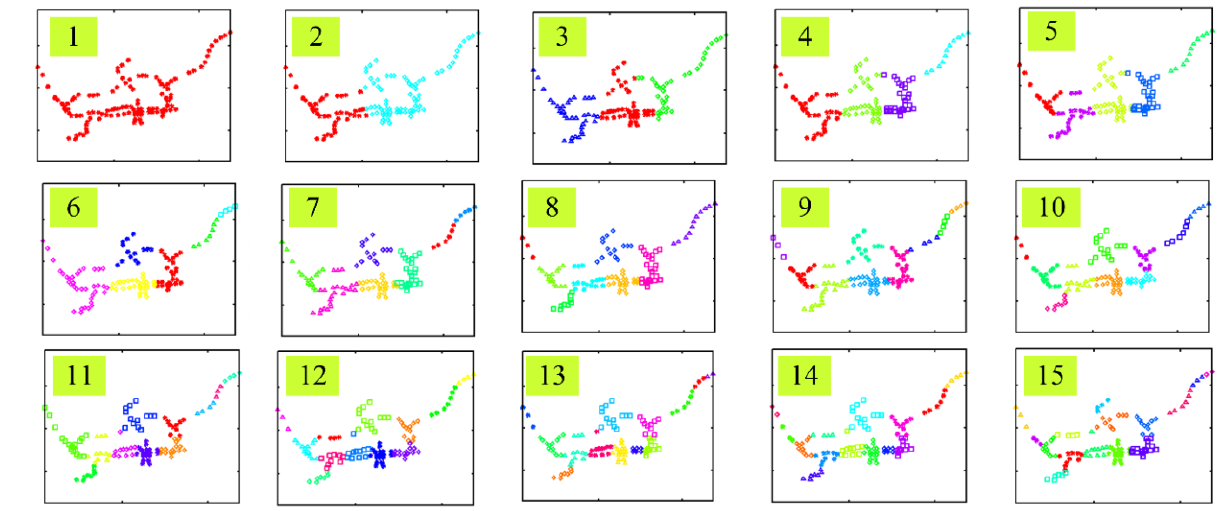
Figure 10. Clustering results for K inside interval [1, 15]